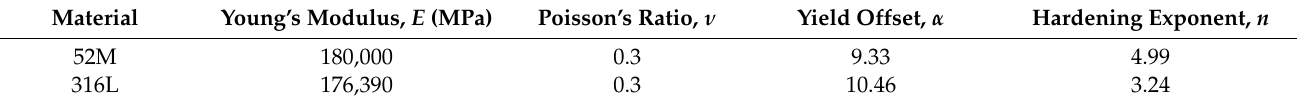
Figure 2. Welded joint sampling and crack location diagram (where I—52M specimen: crack 1, where II—weld line specimen: crack 2, where III—316Lspecimen: crack 3). Table 1. Mechanical property of the material [16,17].